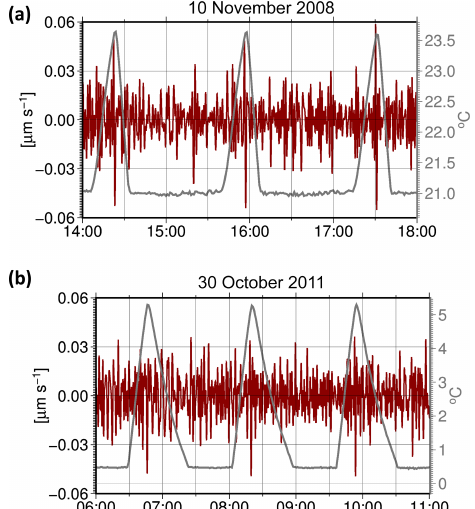
Figure 12. Medium timescale details of the residuals compared to the GRACE-B K-band antenna horn temperature for (a) Novem- ber 2008 (during active thermal control) and (b) October 2011 (with switched off thermal